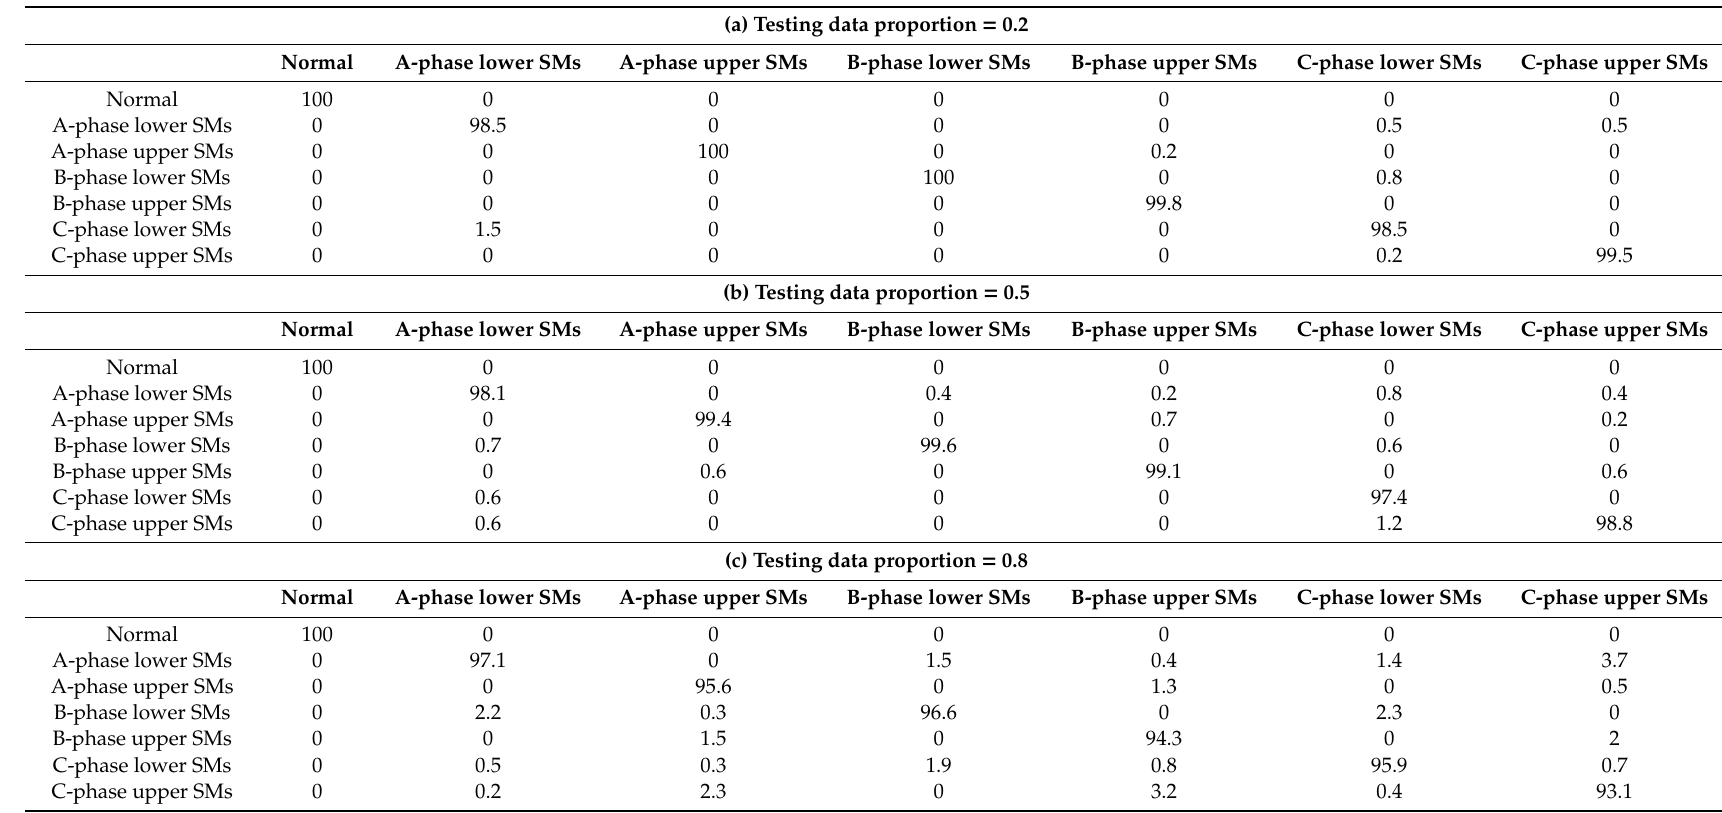
Table 8. Sample confusion matrix of the classification results of the stand-alone SoftMax